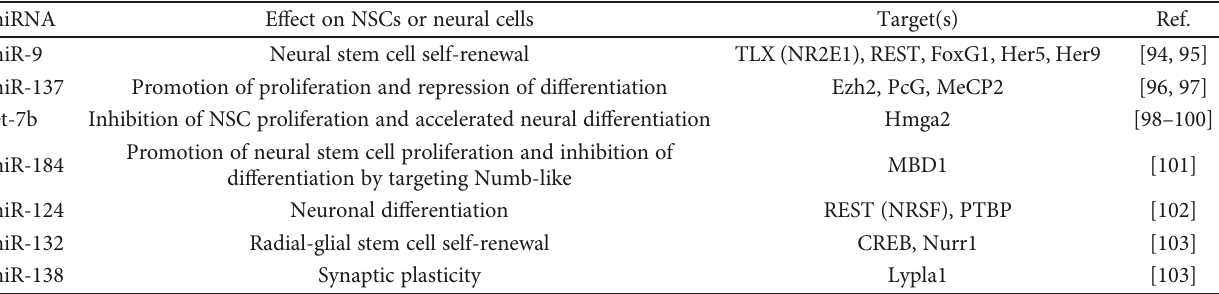
Table 4: Neural stem cell- or neural cell-speci fi c